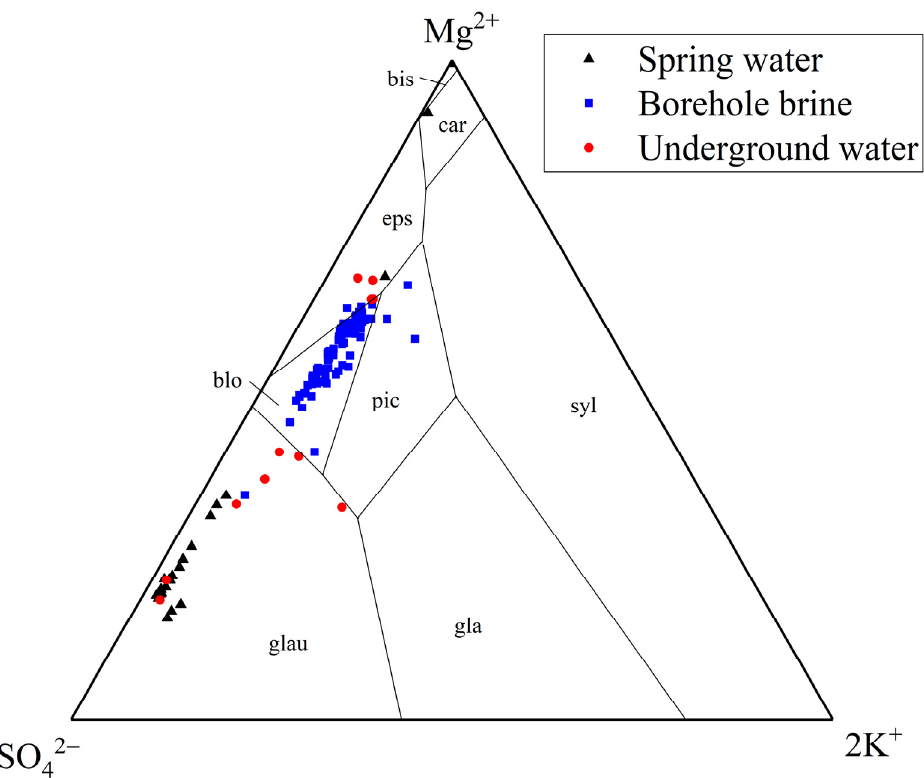
Figure 7. The phase diagram of Na + , K + , Mg 2+ //Cl − , SO 42 − -H 2 O five-element water-element system in the Lop Nor Basin at 25 ◦ C; bis, bischofite; car, carnallite; eps, epsomite; blo, bloedite; pic, picromerite; syl, sylvite; gla, glauberite; glau, glauber